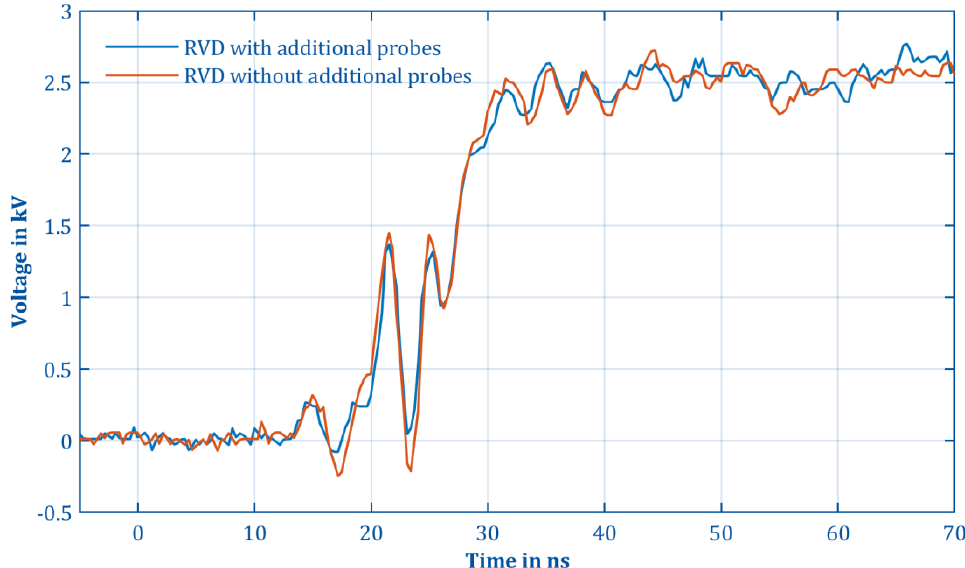
Figure A8. Comparison of the measured output signal of the resistive voltage divider with the three commercially available probes (Testec Elektronik GmbH TT-HV 250, PMK Mess- & Kommunikationstechnik GmbH PHV 1000 and, North Star High Voltage PVM-12HF) connected to the high-voltage input (blue) and without these probes connected (red). The curves are nearly identical, so the influence of the additional probes is measurable, but neglectable.